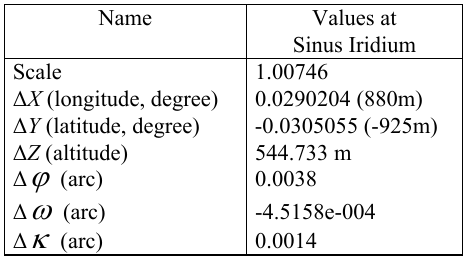
Table 1. Transformation parameters between Chang’E-1 and